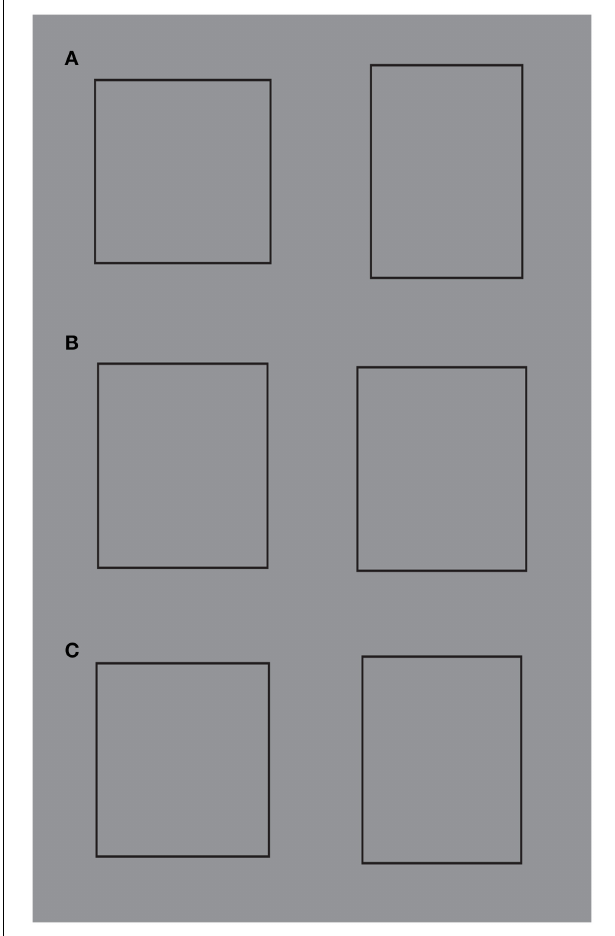
FIGURE 15 | The average squares matched with the conditions illustrated in Figure 14. For further details please see the text.